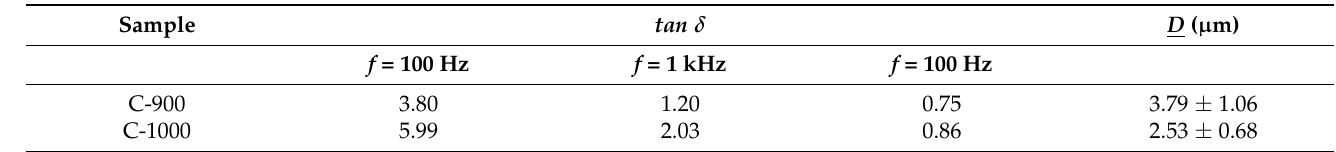
Table 4. Loss factor measurements of ceramic samples, C-900 and C-1000, performed at 100 Hz, 1 kHz, and 100 kHz, at room temperature (25 ◦